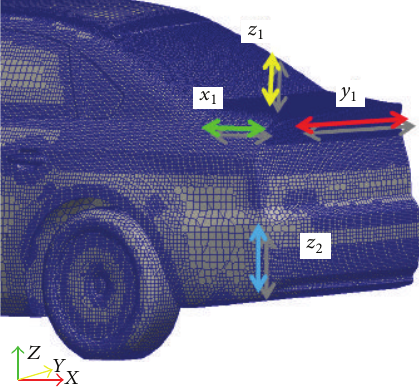
Figure 17: DrivAer model. Shape parameters chosen as design